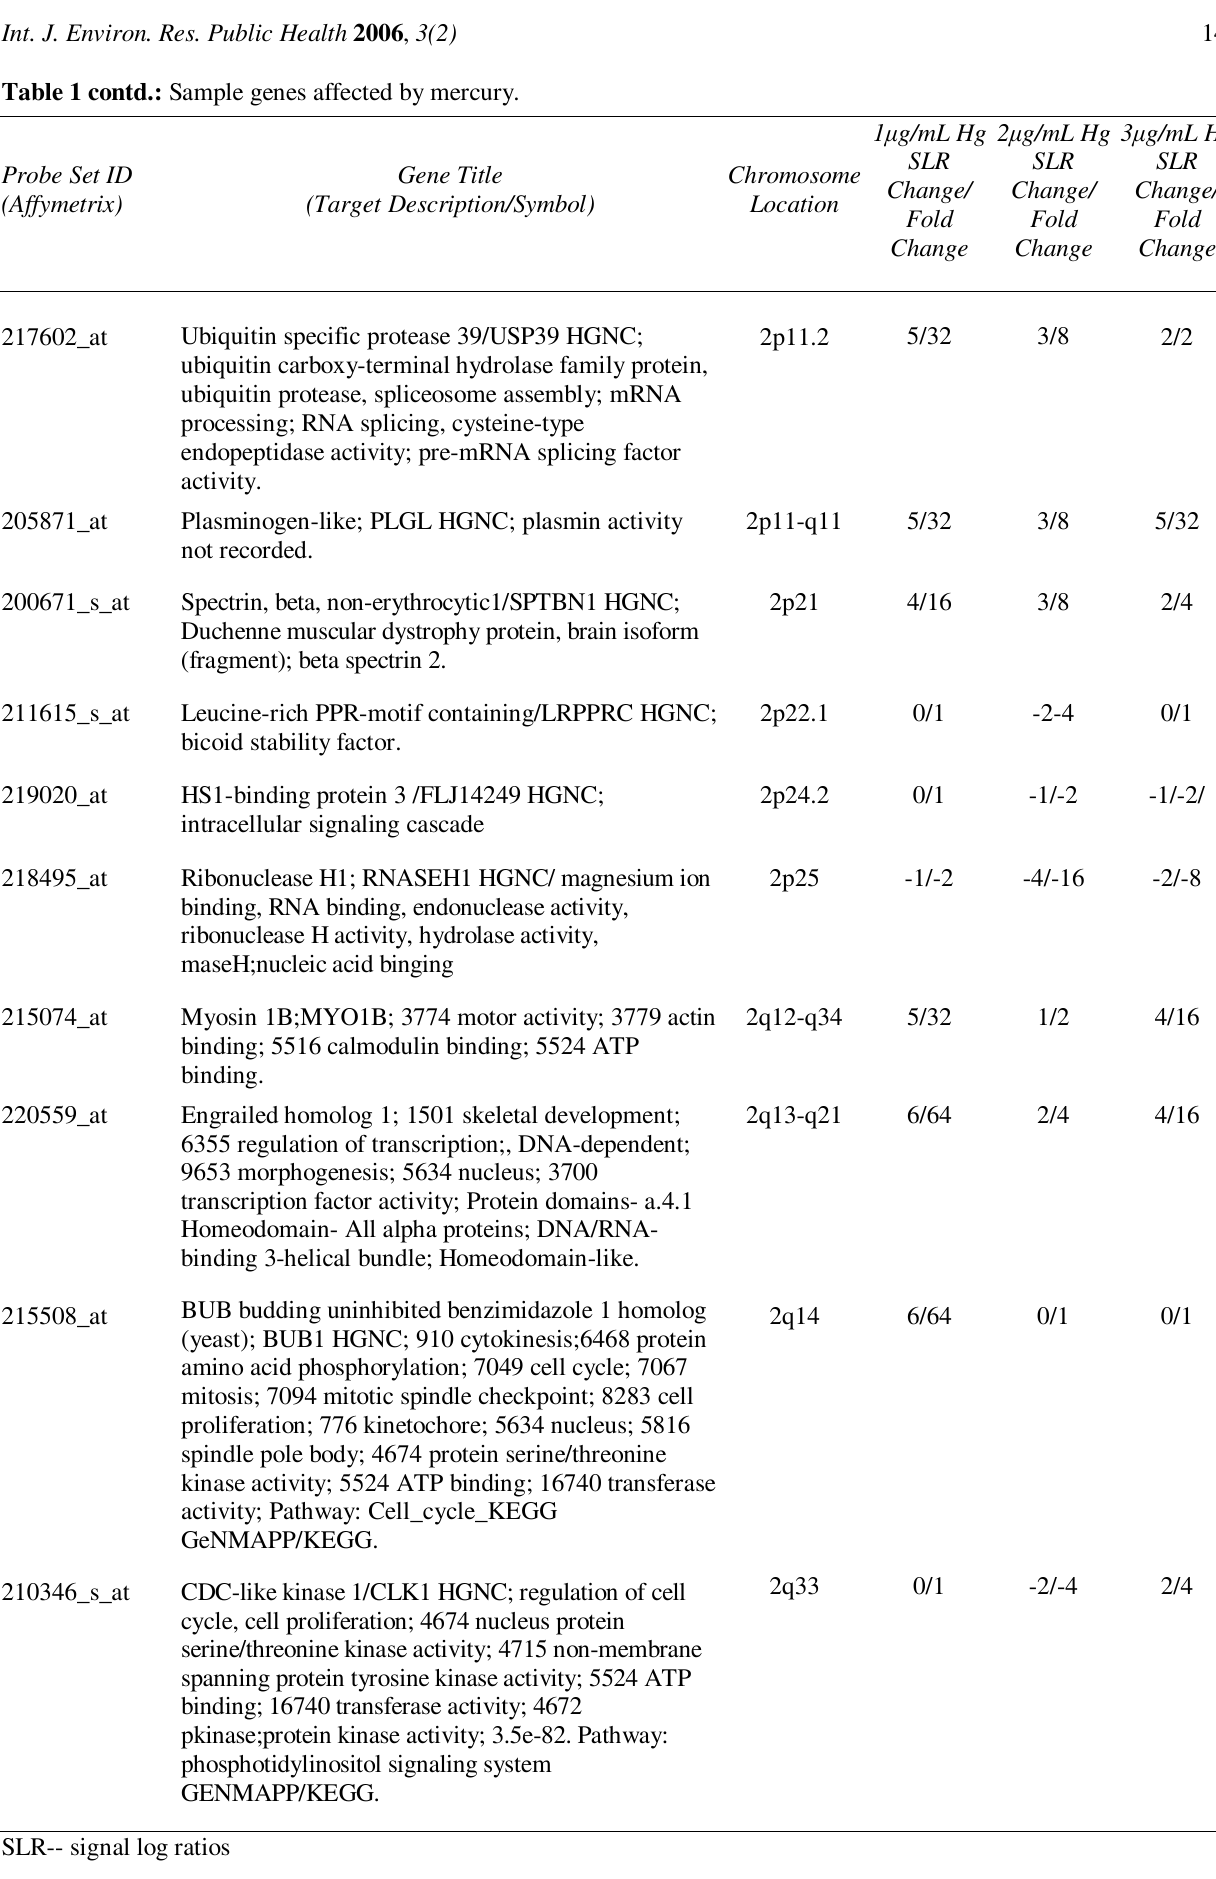
SLR-- signal log ratios